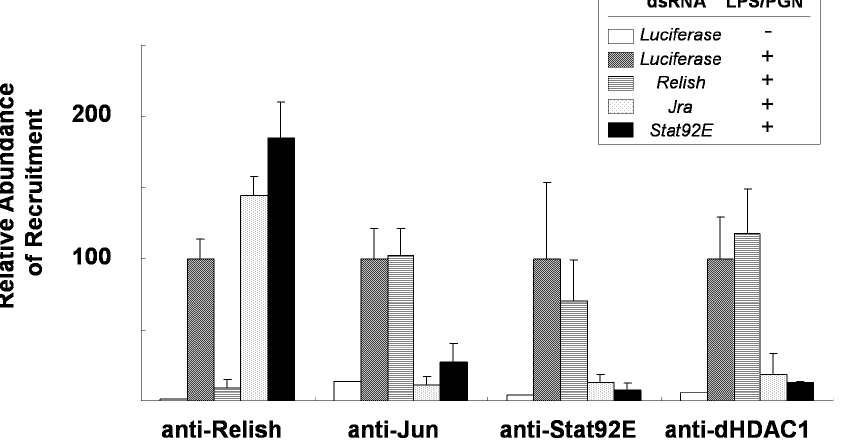
Figure 3. Synergistic Binding of Jra and Stat92E to the Attacin-A Promoter ChIP assays of the transcription factors indicated below using various mutants. SL2 cells were depleted of the transcripts by dsRNA treatment, as indicated in the top box, for 3 d. Then chromatin extracts were prepared before ( (cid:2) ) or after 30 min ( þ ) of LPS/PGN treatment. The amounts of Attacin-A promoter fragments co-precipitated with antibodies against the transcription factors indicated below the data were measured by real-time PCR. The levels were normalized by the input used in each ChIP assay and are shown with standard deviations. These experiments were repeated independently at least three times.